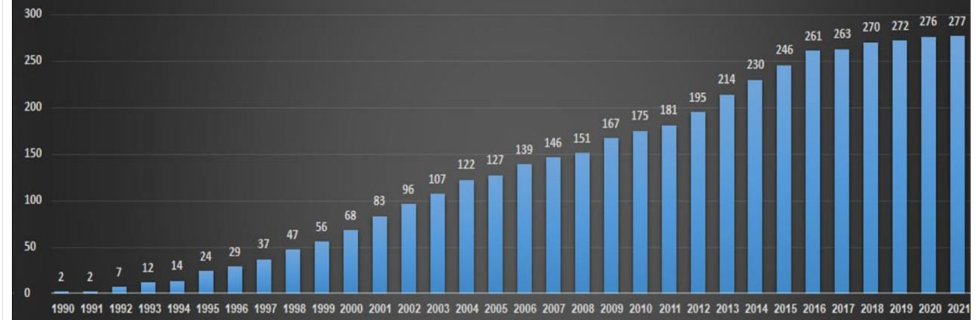
Figure 1. IRD-causative gene identification over the years. The chart shows the total number of known IRD-causative genes each year between 1990 and